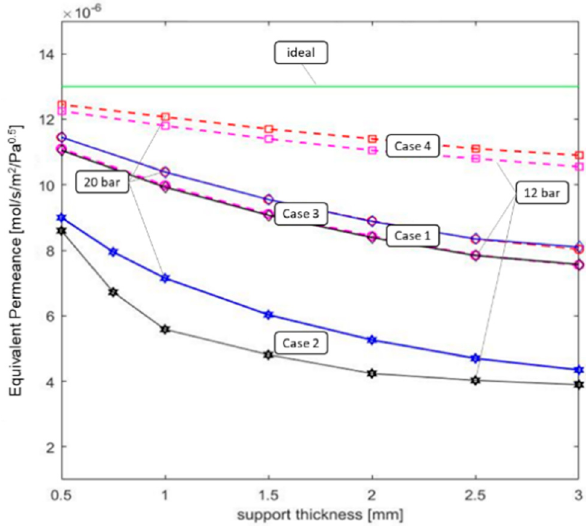
Figure 7. Equivalent permeance calculated at 12 and 20 bar feed pressure for different support thicknesses.